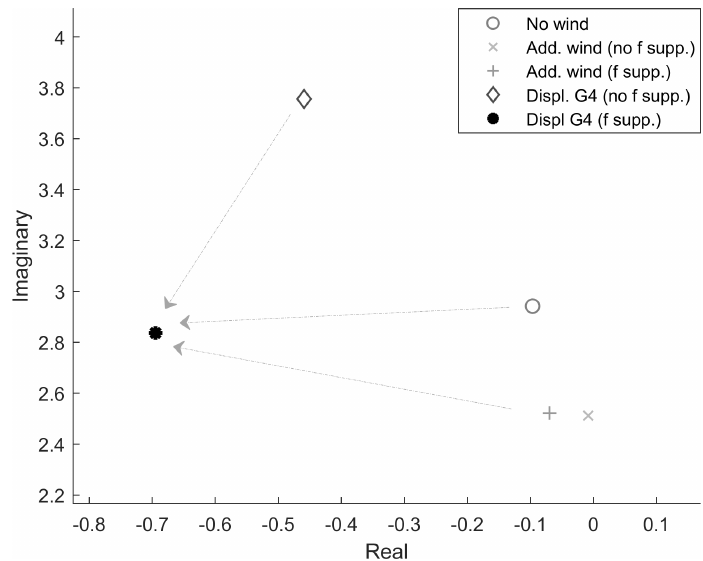
Figure 13. Graphical visualization of inter-area modes for different scenarios.